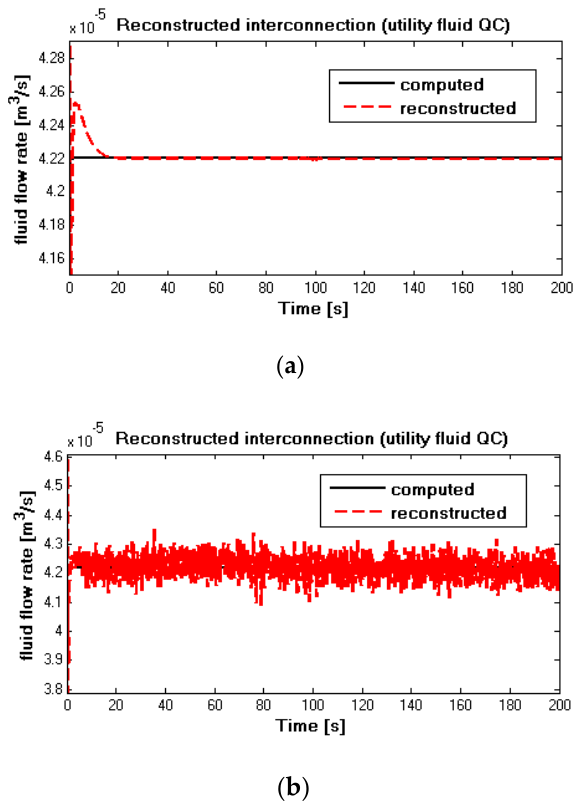
Figure 7. ( a ) Reconstructed and computed Q C (noise-free situation) in case 1; ( b ) reconstructed and computed Q C (noise-corrupted situation) in case